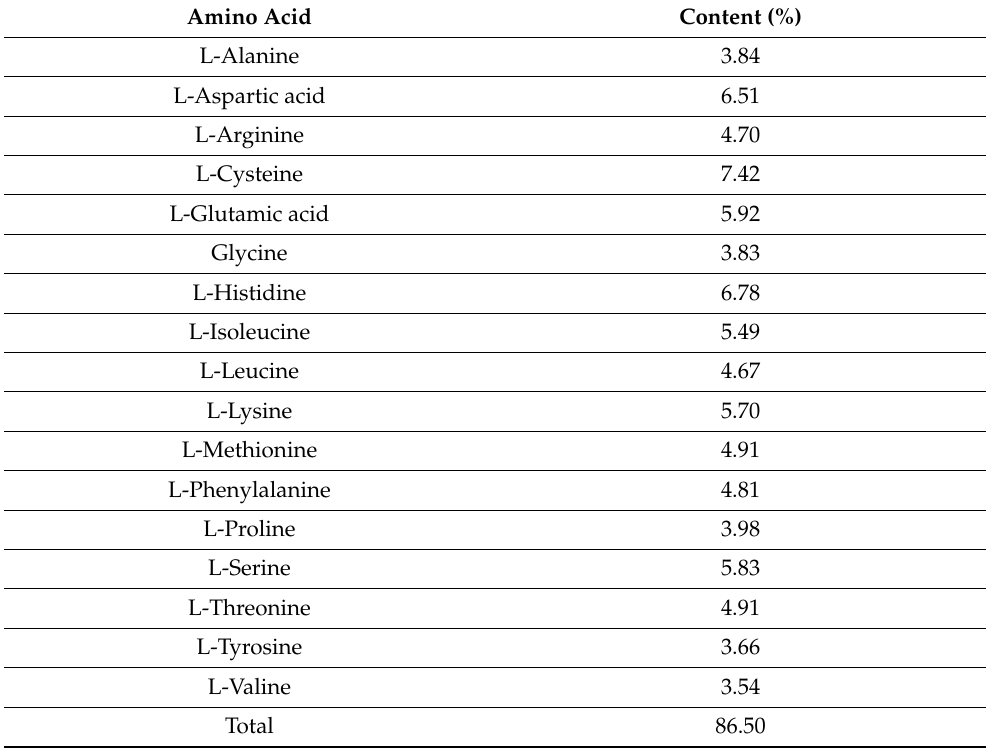
Table 1. Amino acid composition of